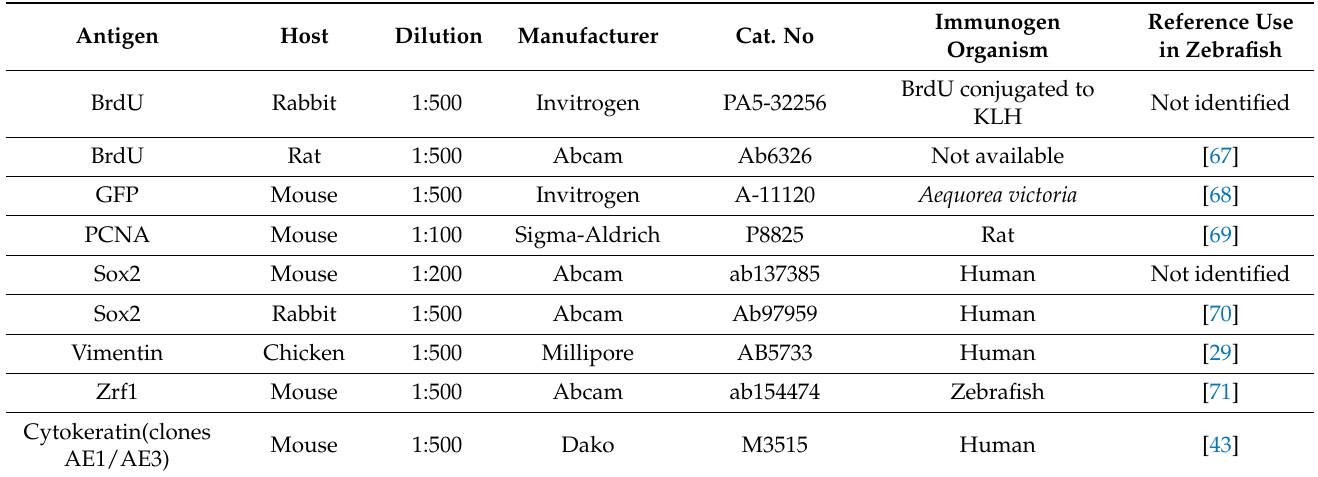
Table 1. Primary antibodies that are used for